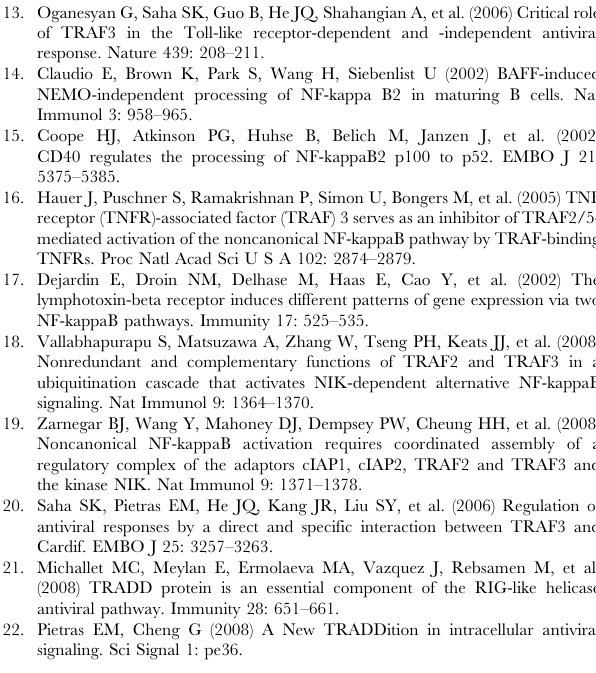
FLAG-MAVS ( E ) or 200 ng of FLAG-TBK1 ( F ). Data represent the fold-activation over the corresponding vector control. Each value represents the mean + / 2 S.D. of triplicate determinations. The data are representative of at least four different experiments with similar results. (TIF) Figure S7 Overexpression of p115 or Sec16A in highly transfectable cell lines inhibited TRAF3-dependent transcriptional activation as depletion of Sec16A or p115. ( A–C ) 293T cells were co-transfected with pGL3-IFN b luciferase reporter gene, plus increasing amounts of indicated plasmids along with 15 ng of His- TRIF ( A ), 15 ng of FLAG- D RIGi ( B ) or 15 ng of FLAG-MAVS ( C ). ( D ) 293T cells were co-transfected with pGL3-IFN b luciferase reporter gene, increasing amount of FLAG-TRAF3, 15 ng of FLAG-MAVS or empty vector and 70 ng of Myc-p115 or EGFP- Sec16A ( D ). ( E–F ) 293T cells were co-transfected with pGL3- ISRE luciferase reporter gene plus increasing amounts of indicated plasmids along with 100 ng of FLAG-TBK1 ( E ) or 15 ng of FLAG-IRF3 5D ( F ). Relative luciferase activity was measured as described in Materials and Methods. Data are representative of at least four different experiments with similar results.